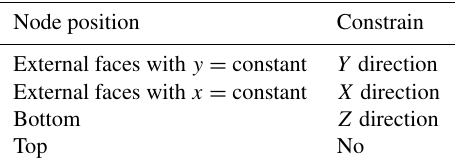
Table 2. Boundary conditions. Node position